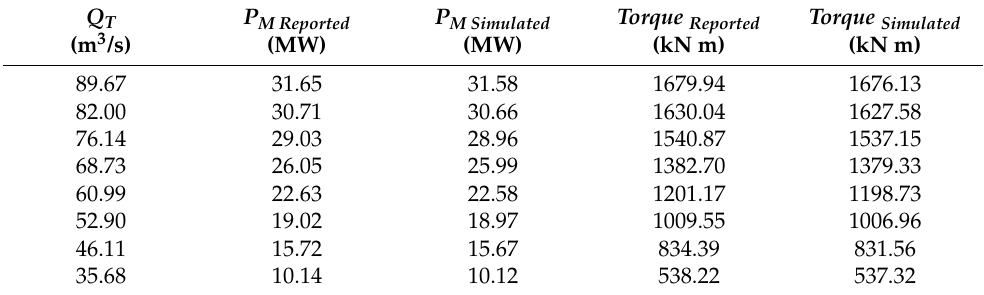
Table 7. Comparison between mechanical power and torque, reported vs. simulated.